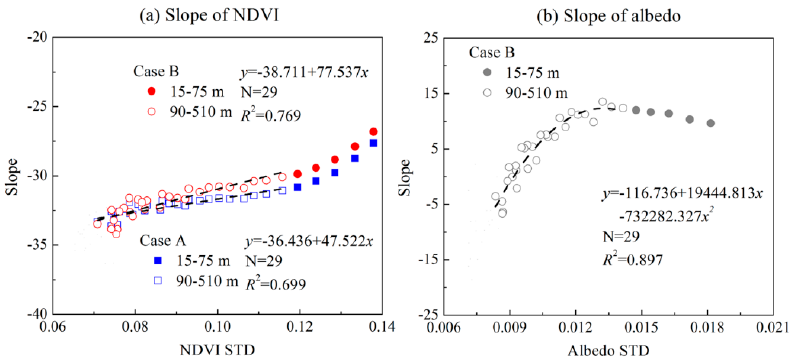
Figure 5. ( a , b ) The relationship between the slopes of the LST-descriptors functions and the STDs of the descriptors in the Zhangye oasis. The regressions are significant at the 0.001 level. The LSTs were simulated from the TASI LST on 10 July 2012.